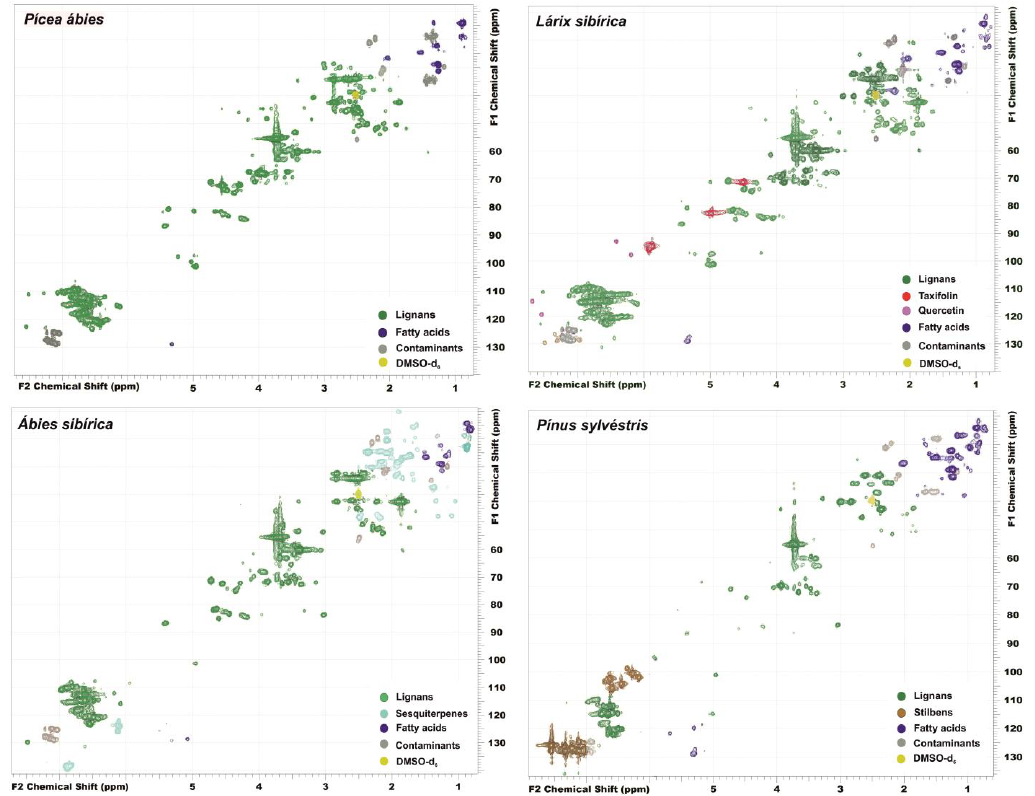
Figure 2. Two-dimensional (HSQC) 1 H- 13 C NMR spectra of the Picea abies , Pinus sylvestris , Abies sibirica , and Larix sibirica knotwood extractives and cross-peaks assignment. Antioxidants 2022 , 11 , x FOR PEER REVIEW Siberian larch is another species in the knotwood extract of which, in addition to lignans, other polyphenolic compounds were found in significant amounts. An HSQC NMR spectrum of this sample contains intense signals of two flavonoids, quercetin and taxifolin, constituting 20% of all the aromatic structures. Unlike Scotch pine knotwood, the lignans in this sample are the main components and are much more diverse. This group is dominated by secoisolariciresinol (28% of the total aromatics content), followed by lariciresinol, todolactol, nortrachelogenin, lignan A, 5-hydroxymatairesinol and its iso- mers, pinoresinol, and vladinol D. Although major compounds listed above have already been previously identified in a larch knotwood [18,36], the latter four minor lignans were found in Larix sibirica knotwood for the first time.